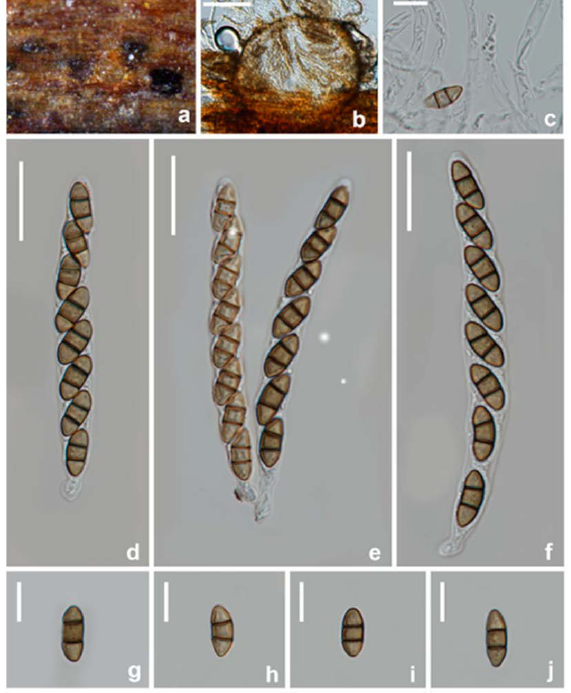
Figure 10. Pestalotiopsis kenyana (Sexual morph, HKAS 123214) ( a ) Appearance of ascomata on host substrate. ( b ) Section of ascoma. ( c ) paraphyses. ( d – f ) asci. ( g – j ) Ascospores. Scale bars: ( b ) = 100 µ m, ( c , g – j ) = 10 µ m, ( d – f ) = 20 µ m.